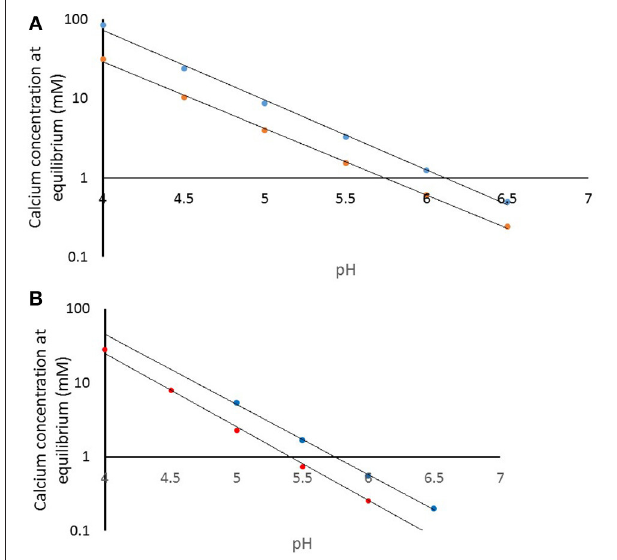
FIGURE 8 | (A) Calculated calcium concentration required for equilibrium at pKsp values of 116 (blue) and 121 (red) for a demineralization solution of 100 mmol/L acetic acid. (B) Calculated calcium concentration required for equilibrium at pKsp values of 116 (blue) and 121 (red) with only that acid or base required for pH